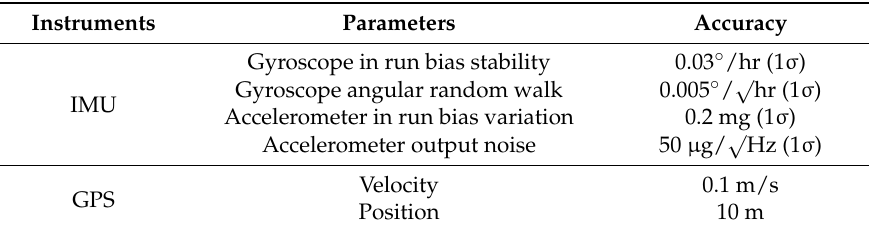
Table 5. Instrument specifications.